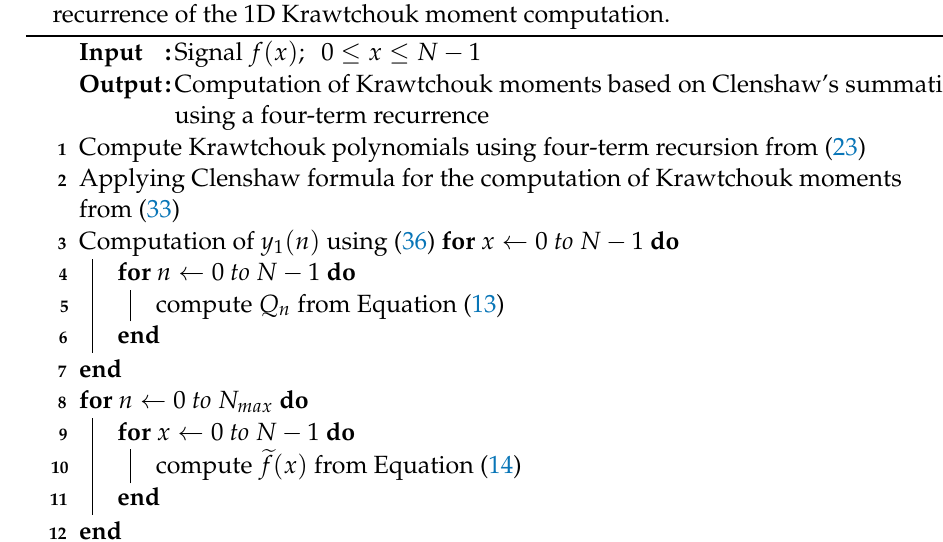
Algorithm 1: Algorithm in pseudo-code for implementing the new four-term recurrence of the 1D Krawtchouk moment